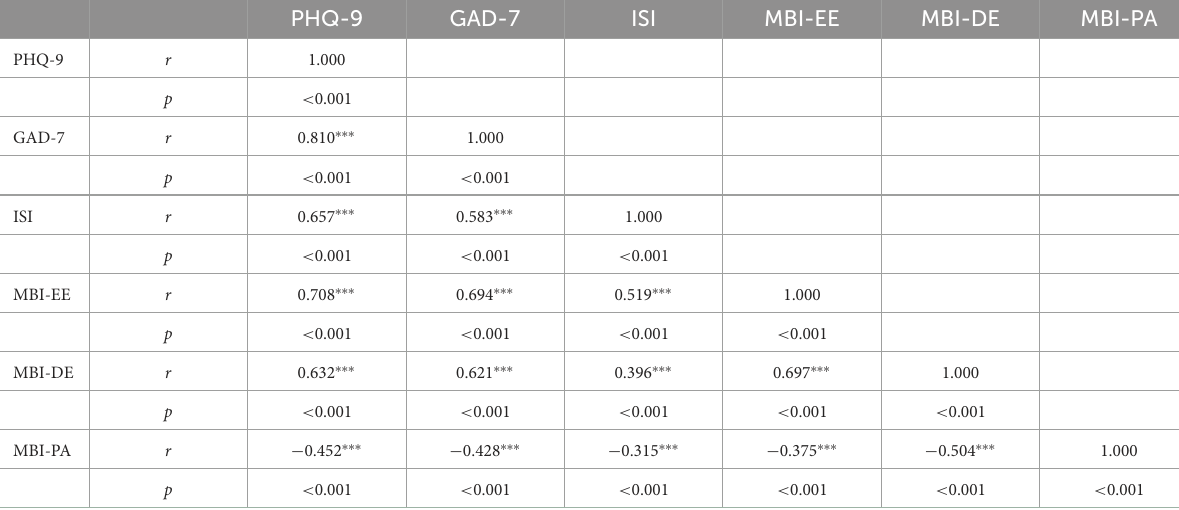
TABLE 6 Correlation analysis of job burnout with anxiety, depression and